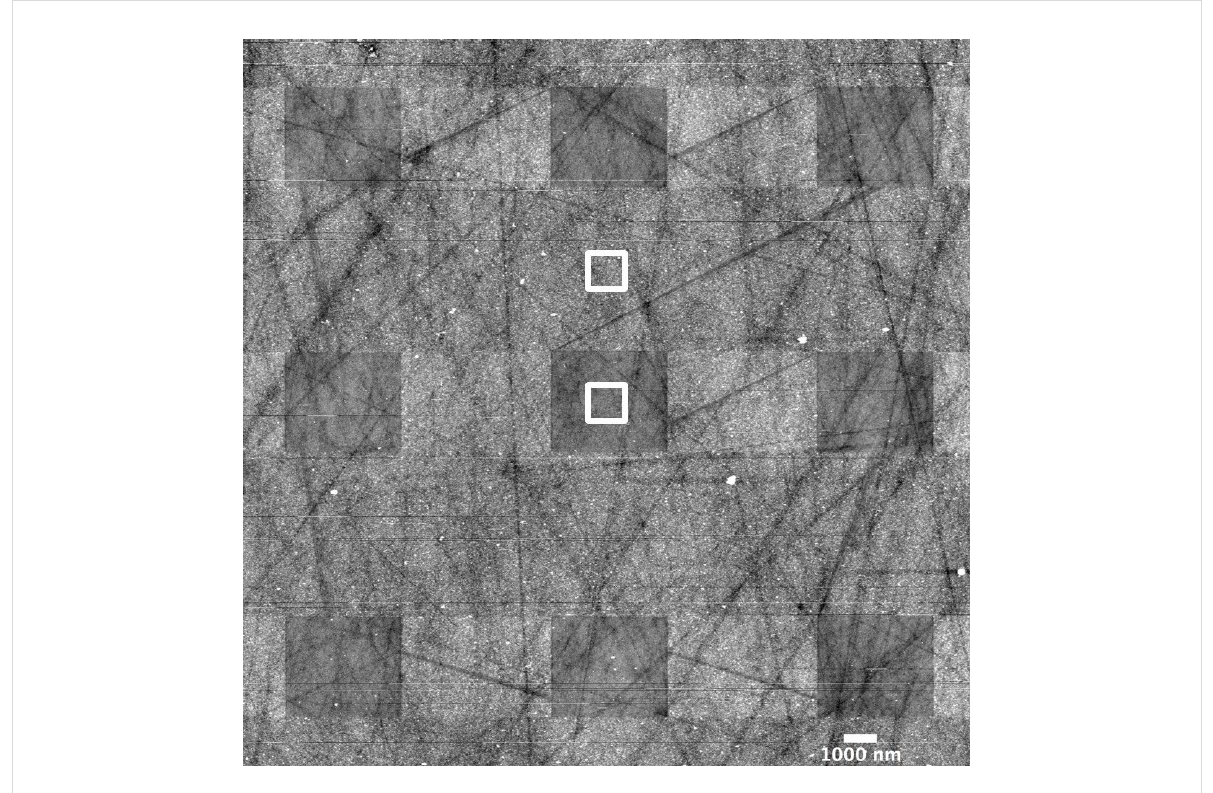
Figure 6: 22 µm scan of the glassy carbon surface collected at the end of electrochemical discharge in 1 M LiNO 3 in TEGDME with ≈ 4600 ppm of water in the electrolyte at discharge current of 350 nA. The experiment lasted for 7 days with the AFM probe continuously scanning the surface in a spiral pattern. More than 3000 tapping mode images were acquired during this time. The average difference in the root mean square Z-values in the two square boxes was 1.5 nm. Thus 344 tapping mode scans change the height of electrochemical deposits on the surface only by a total of only 1.5 nm! Movie 4 (Supporting Information File 5) shows a subset of more than 3000 images along with the discharge curve, documenting subtle changes on the glassy carbon surface at slow discharge